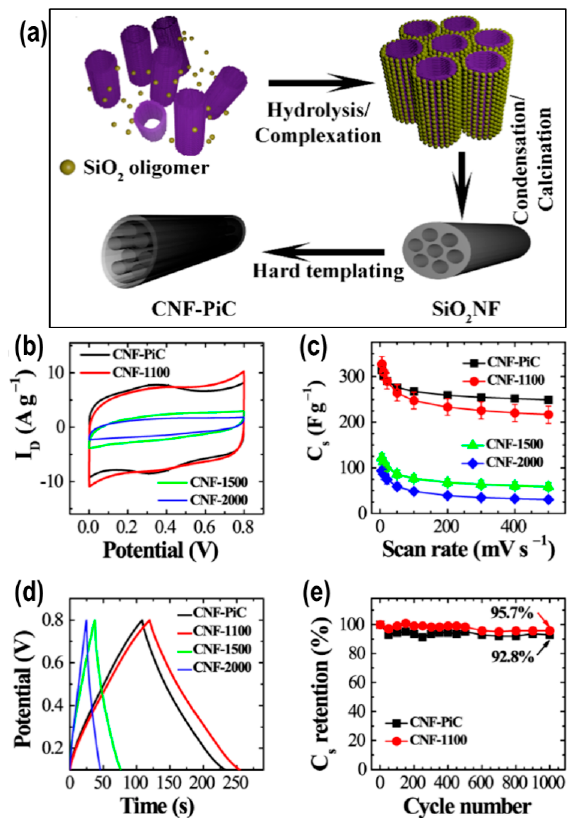
Figure 4. ( a ) Illustration of nanoporous carbons fibers prepared via carbonization and hard method and the electrochemical results. ( b ) CV performance of di ff erent samples at 50 mV s − 1 , s − 1 , ( c ) Capacitance values vs. scan rate for samples carbonized at different temperatures. ( d ) ( c ) Capacitance values vs. scan rate for samples carbonized at di ff erent temperatures. ( d ) Galvanostatic charge − discharge performance at 1 A g − 1 . ( e ) Capacity retention performance recorded at 10 A g − 1 . Reproduced from Reference [132]. Copyright American Chemical Society,